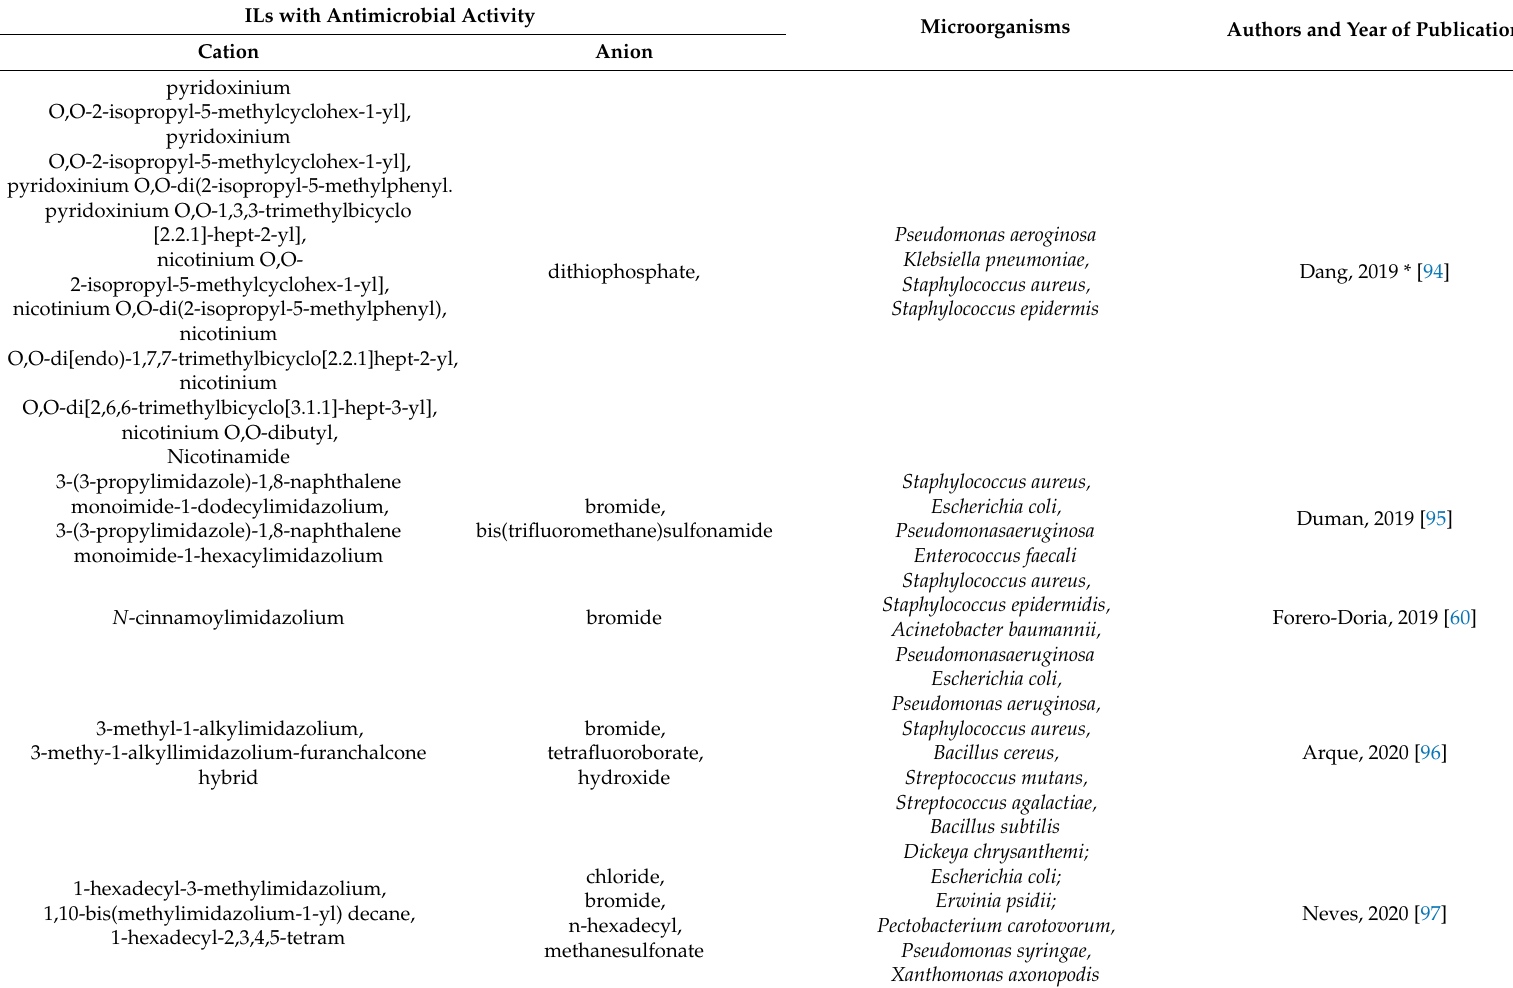
Table 1. Cont . ILs with Antimicrobial Activity